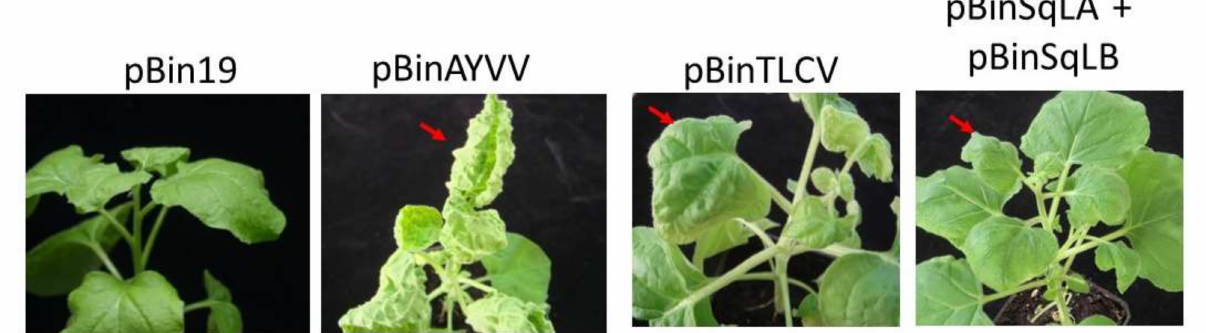
Figure 1. Symptoms on N. benthamiana caused by infectious constructs of specific begomovirus. A. tumefaciens cells harboring the infectious constructs of various begomoviruses as indicated on the top were infiltrated into the leaves of N. benthamiana . The symptoms were recorded at 21 days post inoculation (dpi). The prominent leaf curling symptoms were indicated by the red arrows. pBin19, vector only control; pBinAYVV and pBinTLCV, infectious constructs of Ageratum yellow vein virus strain NT (AYVV-NT) and Tomato leaf curl virus strain TC (TLCV-TC), respectively; pBinSqLA + pBinSqLB, infectious constructs of DNA A and B, respectively, of Squash leaf curl virus strain YL